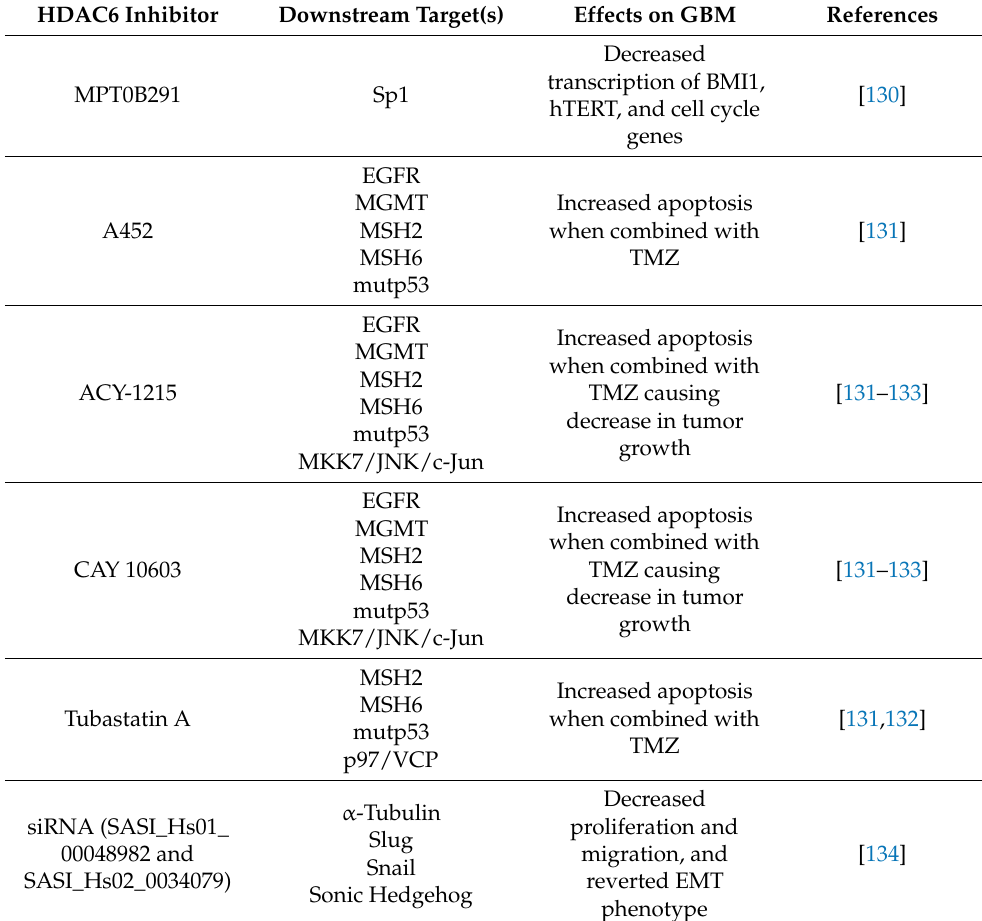
Table 1. HDAC6 inhibitors and their targets for controlling growth of